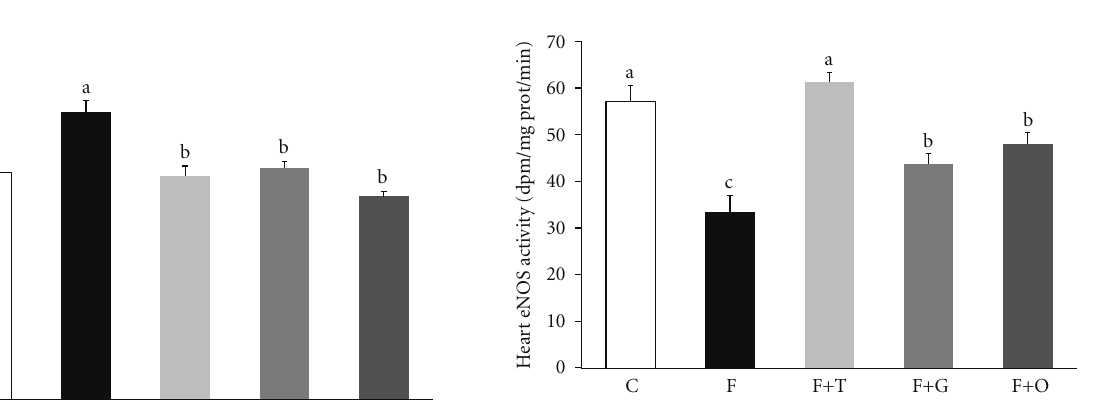
Figure 3: Heart endothelial nitric oxide synthase (eNOS) activity from C, F, F+T, F+G, and F+O groups. Values are expressed as mean ± SEM, ( n = 6); bars with di ff erent superscripts di ff er, P < 0.05. insulin, insulin resistance index, and triglycerides ( P <